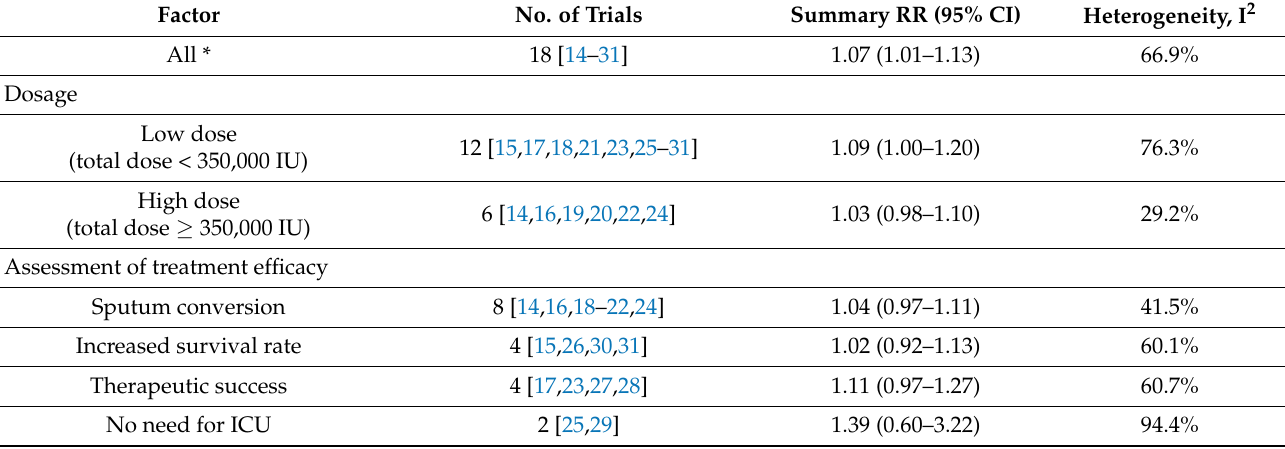
Table 2. Summary of risk of bias assessment for randomized, double-blind, placebo-controlled trials based on the Cochrane Risk of Bias Tool (mean score = 5.5). Table 5. Efficacy of vitamin D in the treatment of the upper respiratory infections in random-effect meta-analyses by various